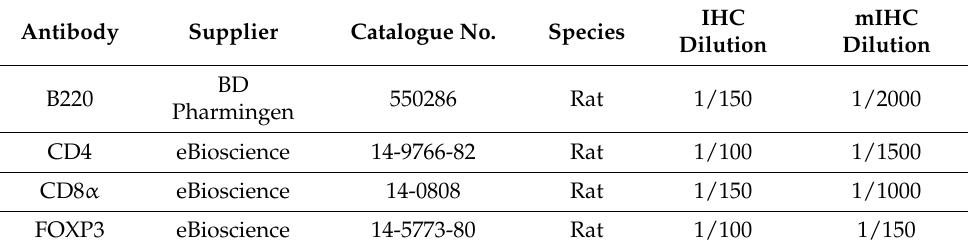
Table 3. List of primary